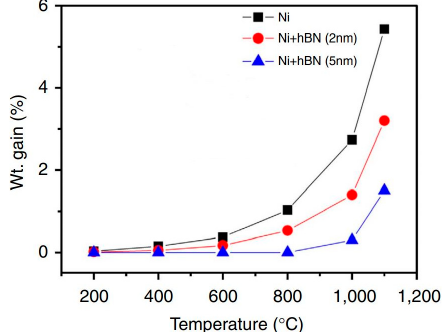
Figure 15. Weight gain (%) of bare Ni, 2 nm hBN-coated Ni and 5 nm hBN-coated Ni after 5 min oxidation in air at different temperatures. Adapted with permission from ref. [169]. Copyright 2013 Springer Nature.